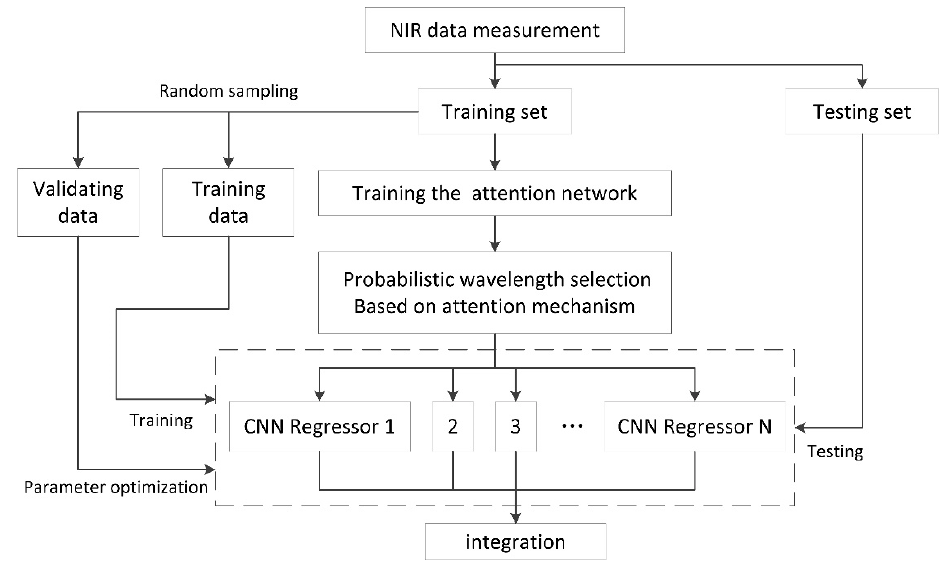
Figure 1. Architecture of the proposed attention mechanism ensemble convolutional neural net- work (AM-ECNN).